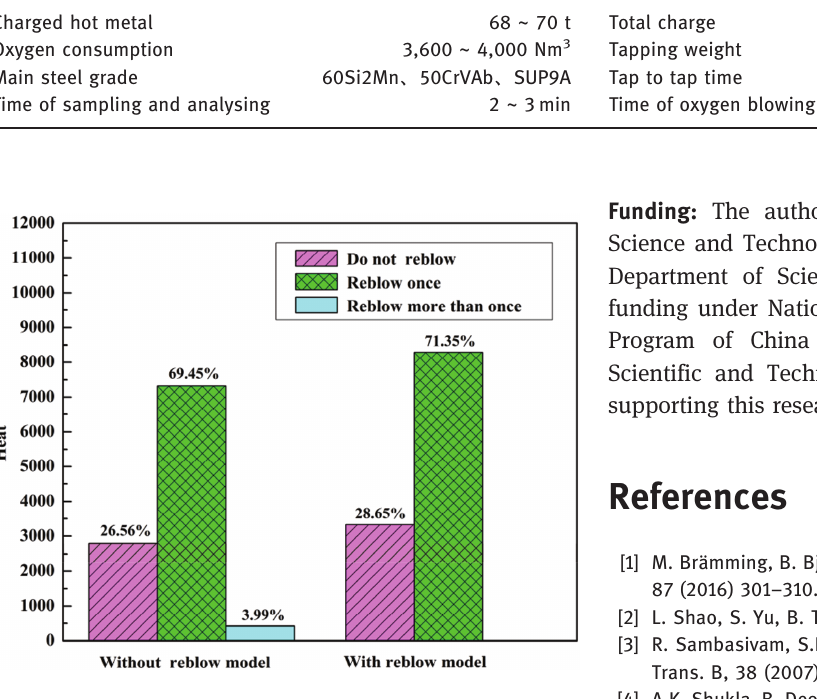
Figure 6: Change of reblow rate with application of the reblow